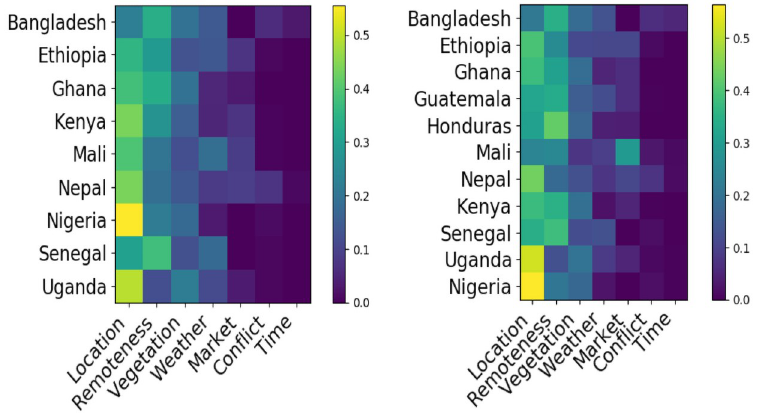
Fig 6. Mean relative variable importance across survey years, indexed by country and data source. (Left) Sequential (Right) Contemporaneous.